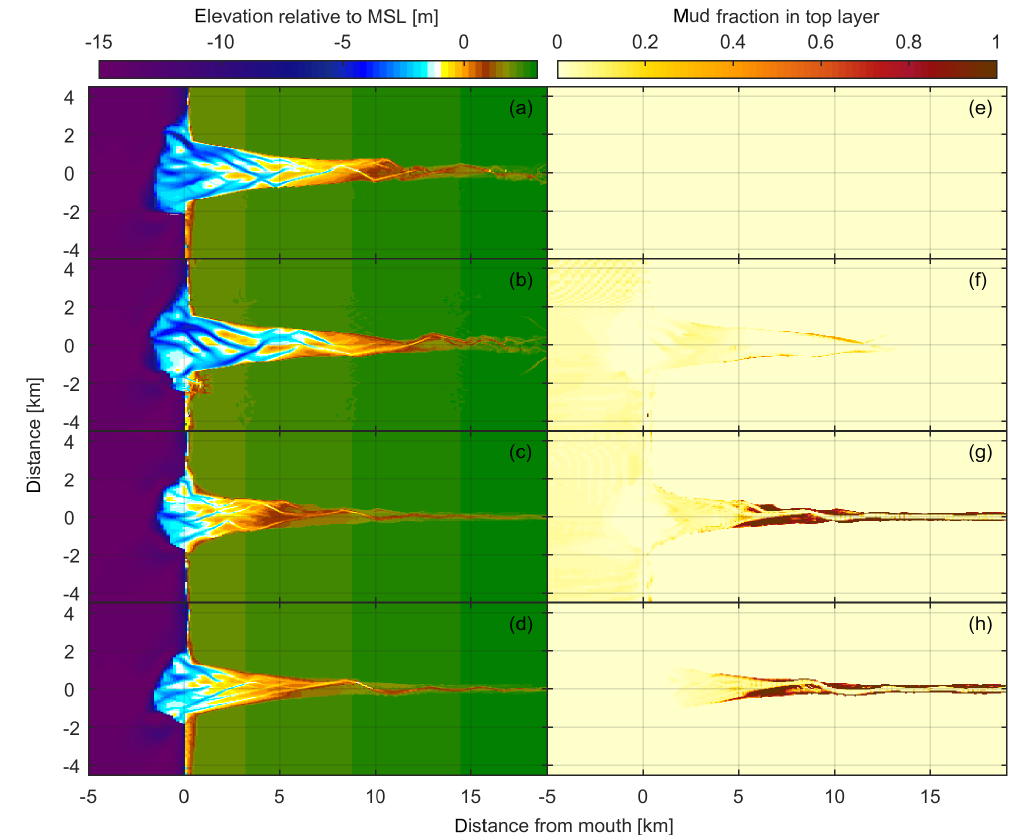
Figure A10. Effects of mud source in the presence of waves (run 28, 27, 25 and 29). The left column shows the final bathymetry of model runs after 1250 years and the right column shows mud fractions in the top layer of the bed. Run with (a, e) only sand, (b, f) marine mud input (default), (c, g) marine and fluvial mud input and (d, h) fluvial mud